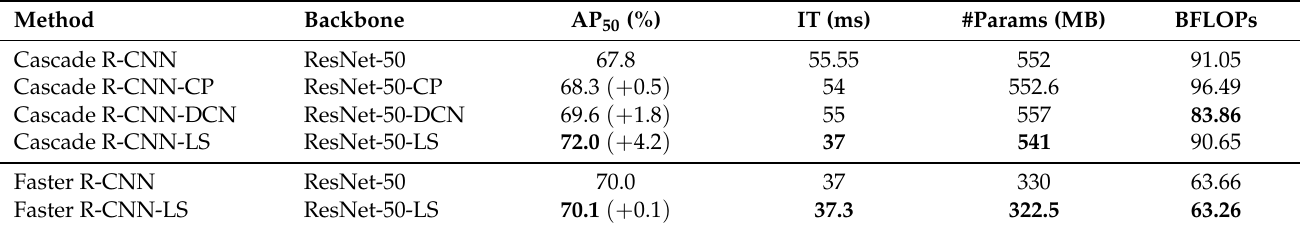
Table 2. Experiment results on AIR-SarSHIP-1.0. The postfixes of “CP”, “DCN”, and “LS” in the Method column indicate the different sparse density feature extraction modules in the network, which are pooling after extraction, deformable convolution, and the proposed lifting scheme layer, respectively. The evaluation metrics include detection performance metrics of average precision at IOU threshold = 0.5 (AP 50 ) and network efficiency metrics of inference time (IT), the number of parameters (#params), and billion float operations (BFLOPs). The values in the parentheses in the AP 50 column represent the increment compared with the baselines. The best results are in